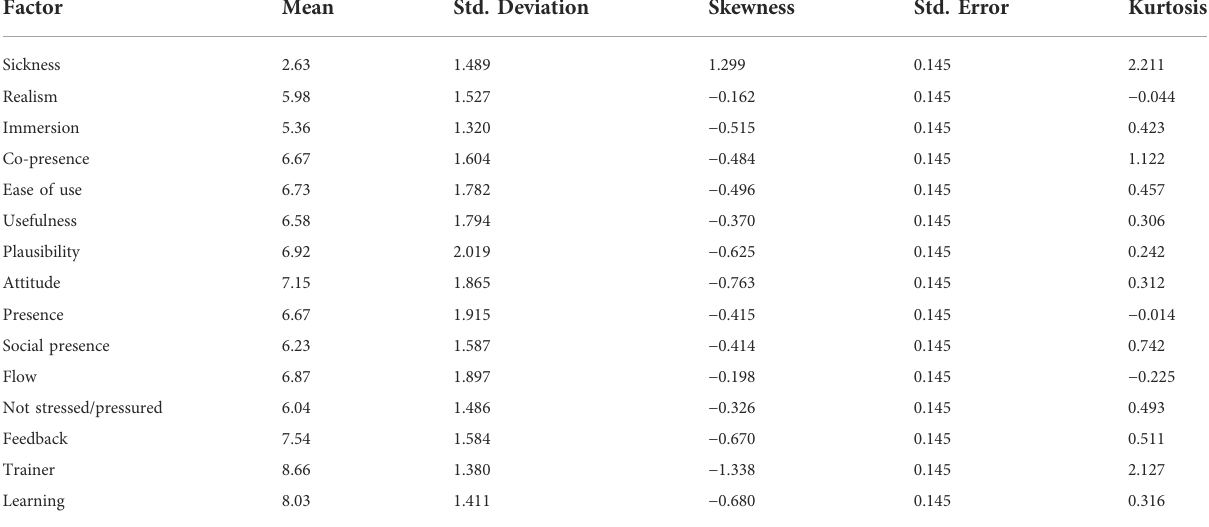
TABLE 3 Measures of VR training experiences and learning outcomes. Factor Mean Std.